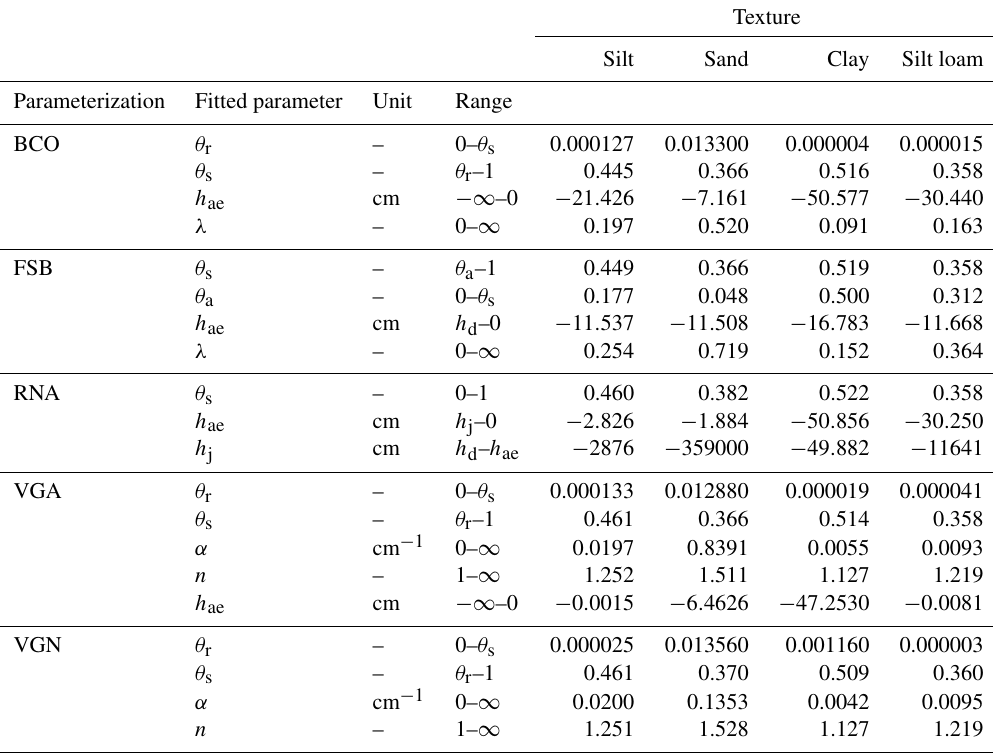
Table 1. The fitting parameters for five parameterizations, their physically permitted ranges, and their fitted values for four textures. The three-character parameterization label is explained in the main